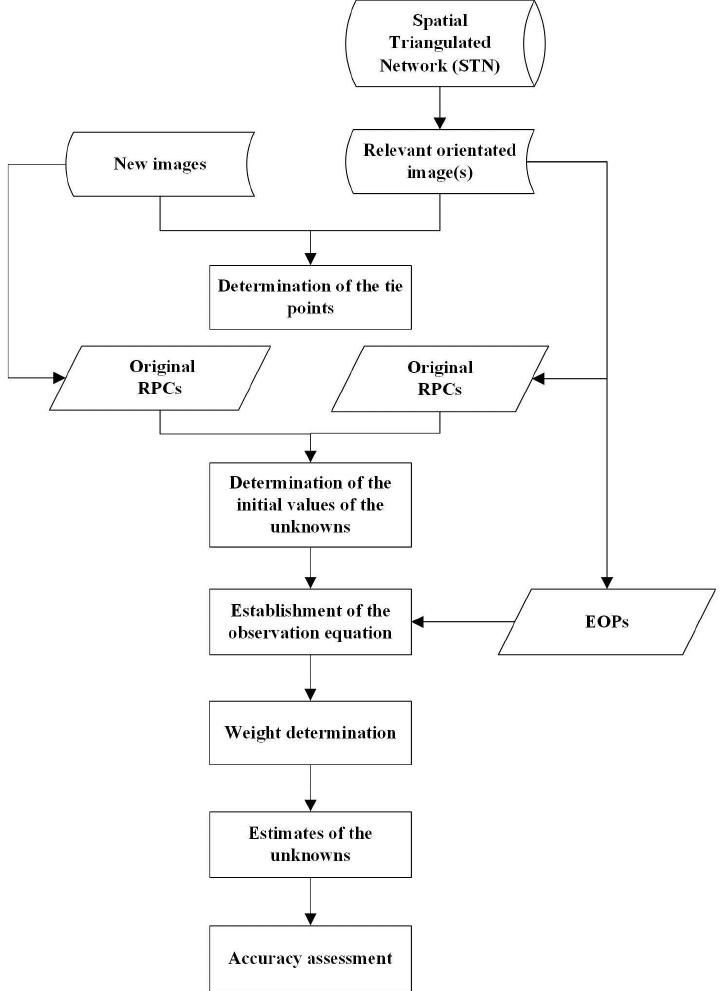
Figure 1. The workflow of the RFM based geo-positioning method without using